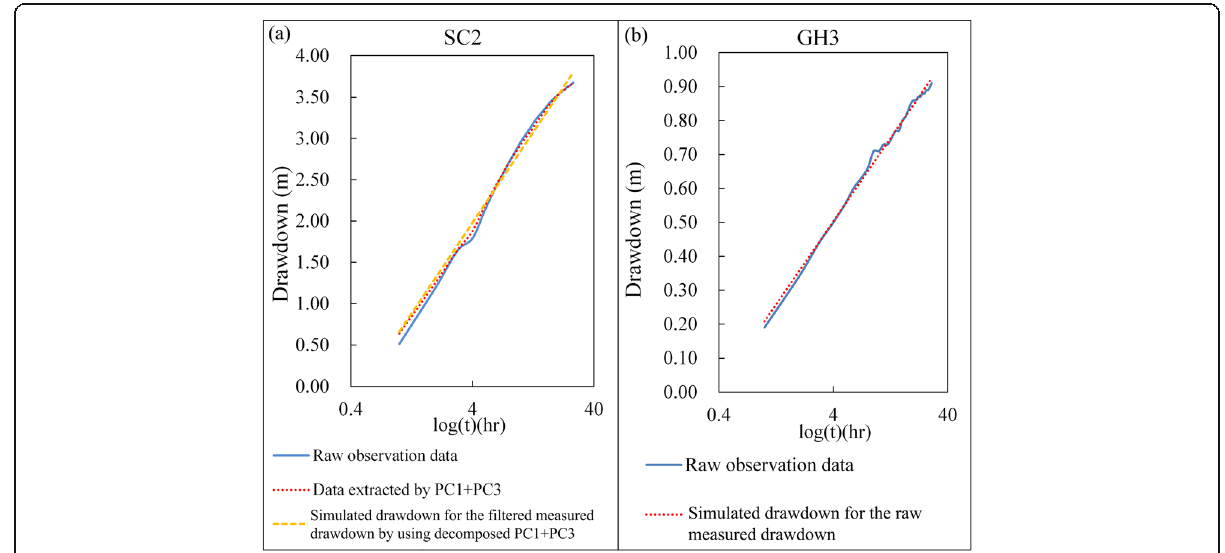
Fig. 16 Comparison of the measured, filtered, and simulated post-seismic drawdown hydrograph: (a) SC2 and (b)